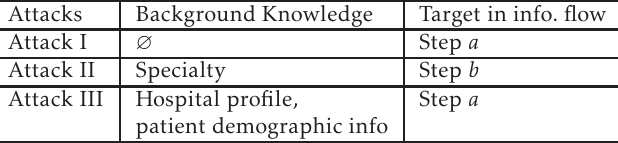
Table 3. Modeling P 3 I data and background-knowledge: This table describes a scenario that involves one patient and five hospitals that appear to be positive in P 3 I, h 1 ,. . . , h 5 . We consider two cases: one that all five hospitals are true positives, and one that among the five, h 2